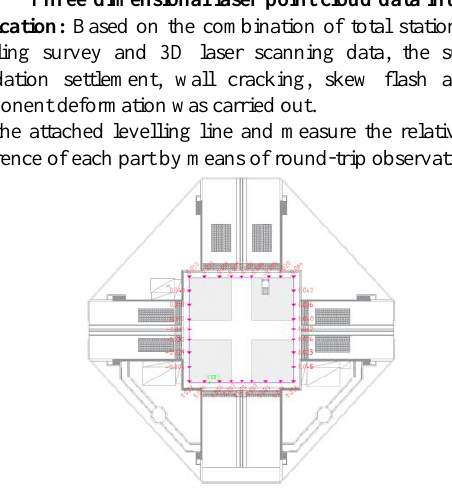
Figure 3. Clock Tower Base Platform level measurements